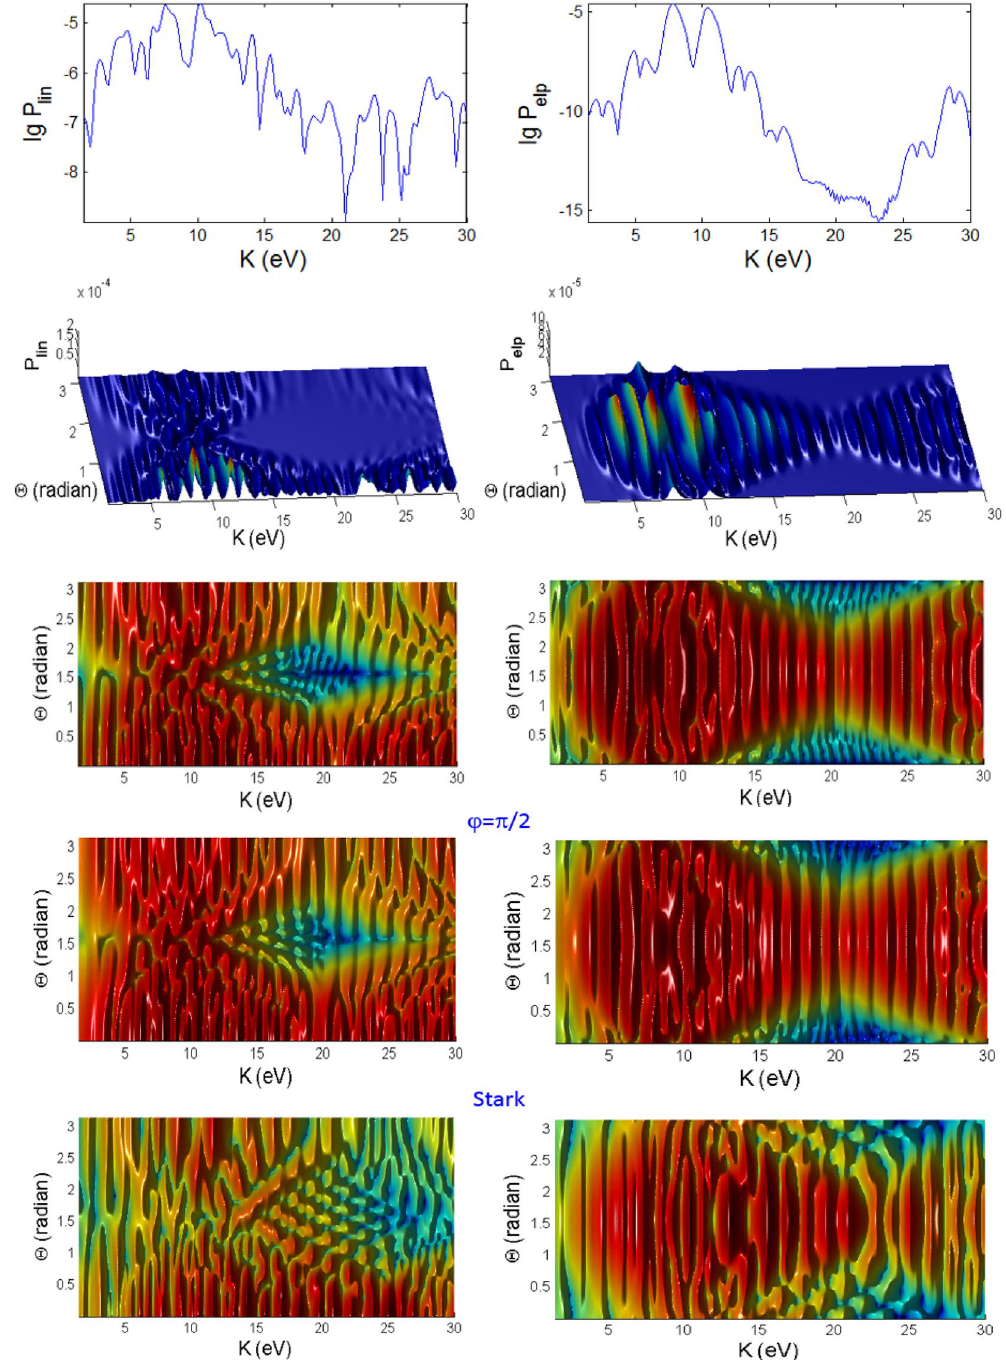
Figure 12. Photoionization probability for t p = 10 fs , versus angle Θ at Φ = 0 and kinetic energy ( K ) for Case A characterizing the intermediate regime, with no Stark effect and no CEP. Only the panels labelled with Stark have finite coefficient = . ≈ b E t . The bottom panels (reddish color) are K - Φ map with probability on log